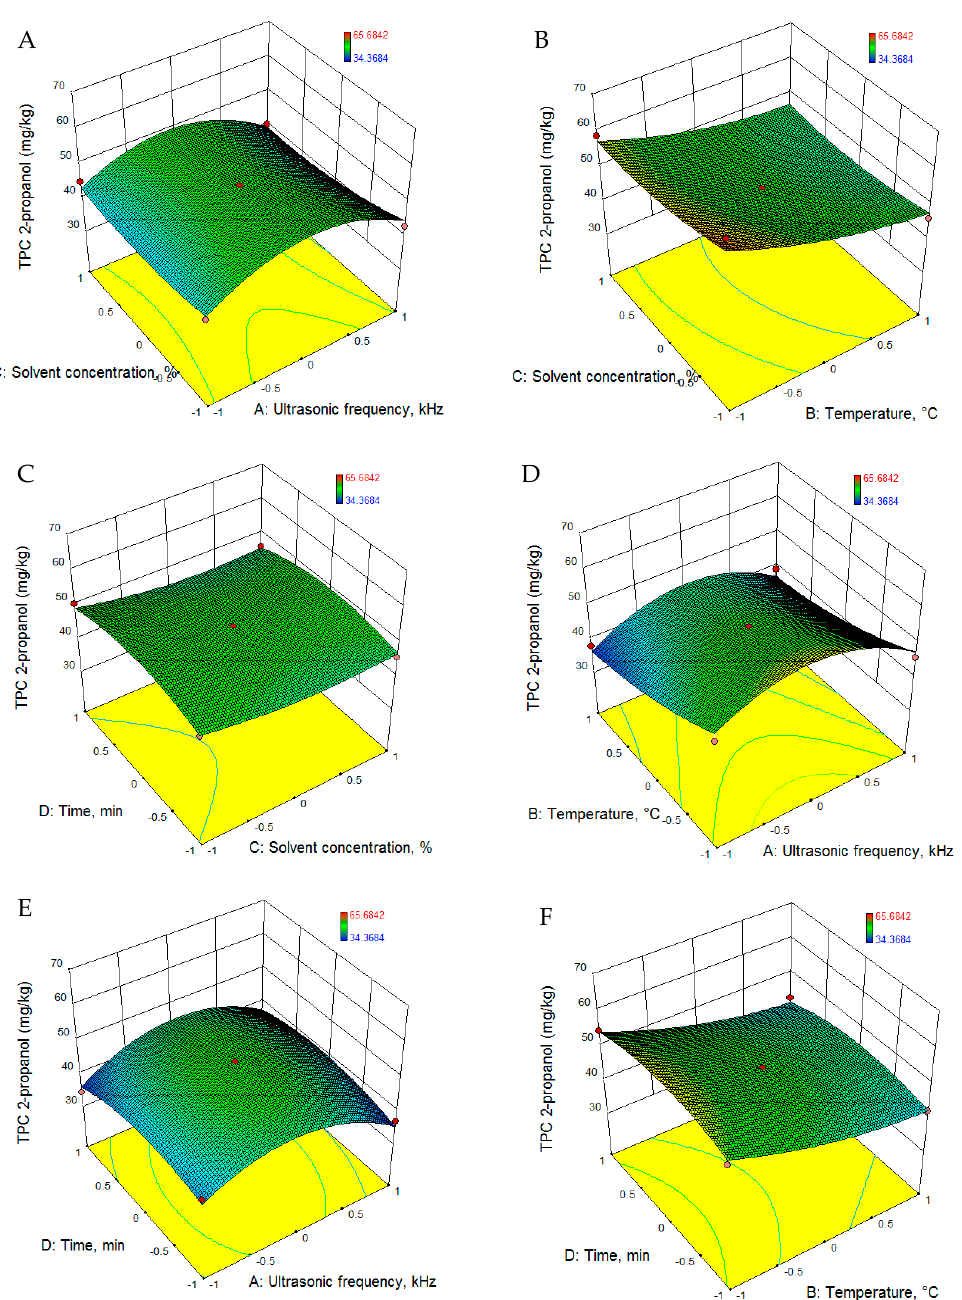
Figure 3. RSM graphs of TPC extraction evolution using 2-propanol as solvent. TPC: total phenolic content.